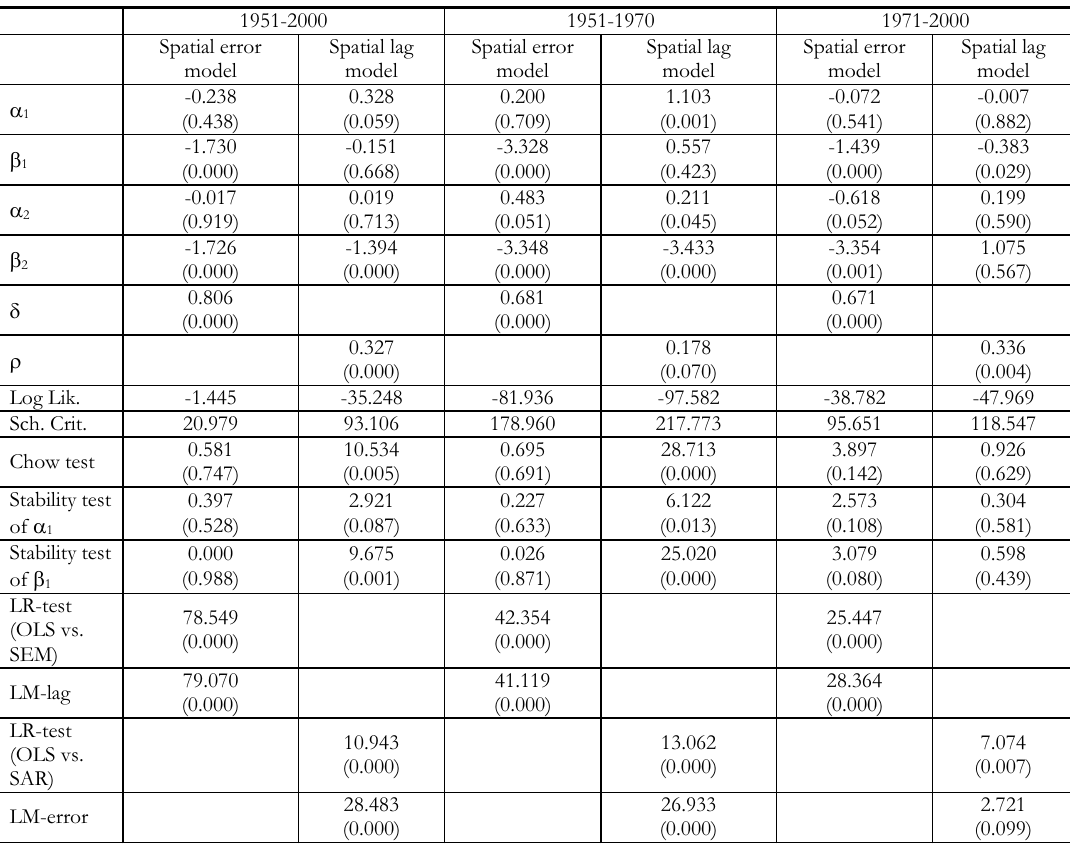
Per Capita Income Growth of Italian Provinces Spatial Dependence Models with Mutiple Regimes – ML